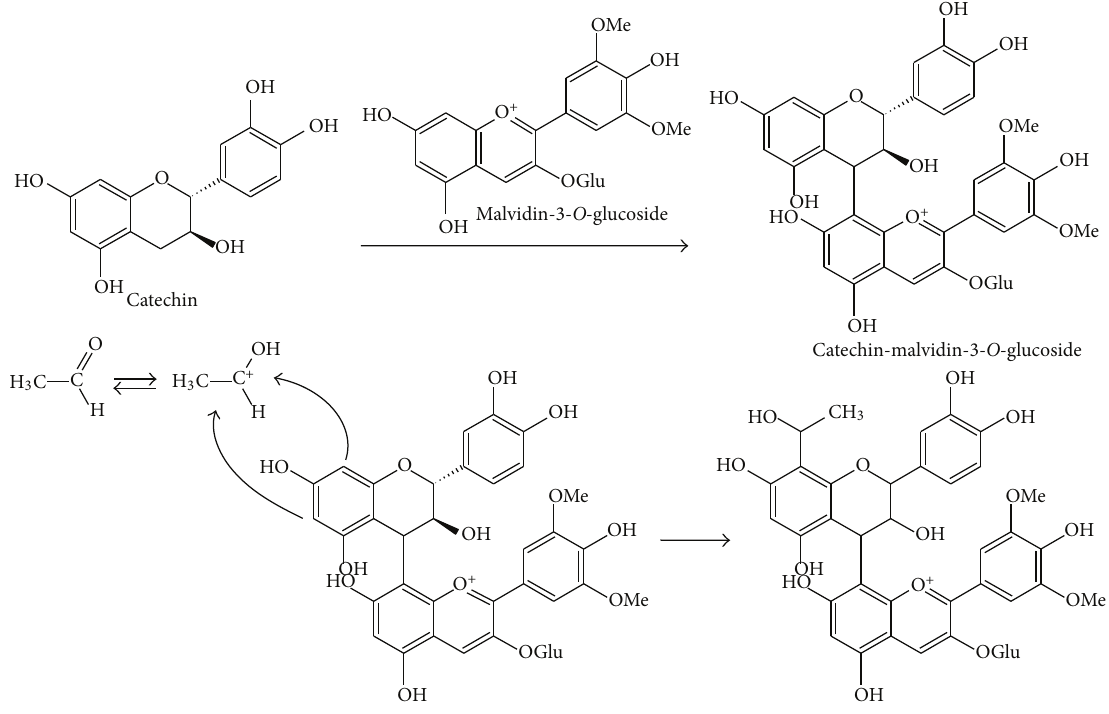
F 5: Proposed reaction mechanism between acetaldehyde and catechin-malvidin-3- O -glucoside